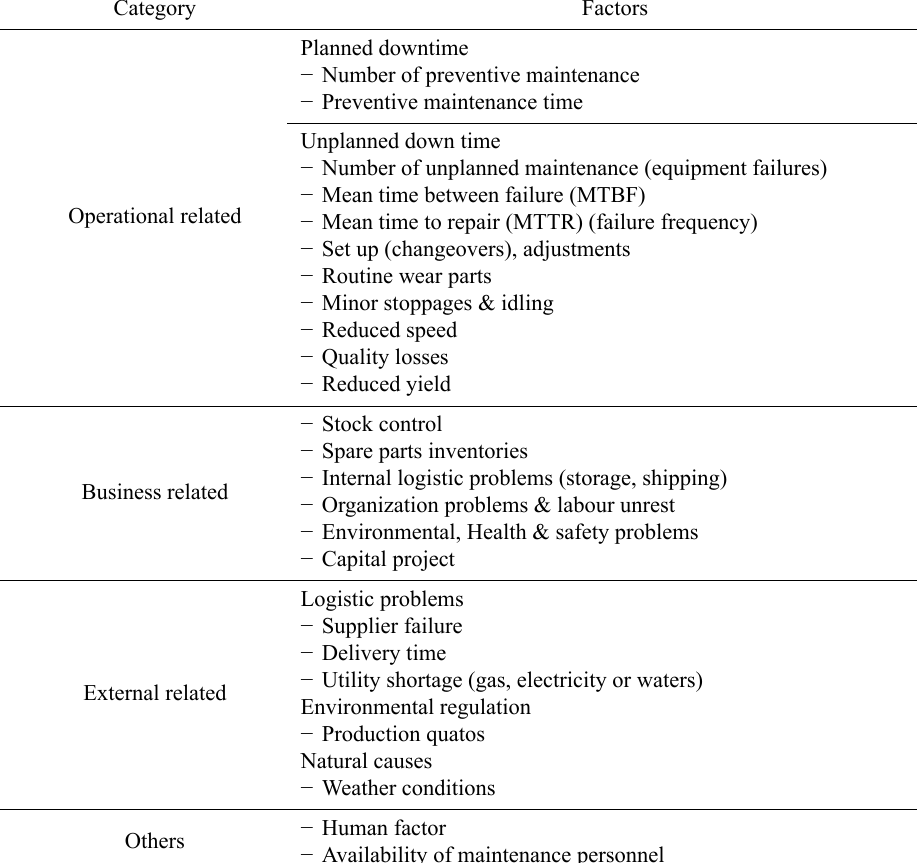
Table 3. Factors affecting TPM (Braglia et al. 2009, Muchiri Pintelon 2008) Category